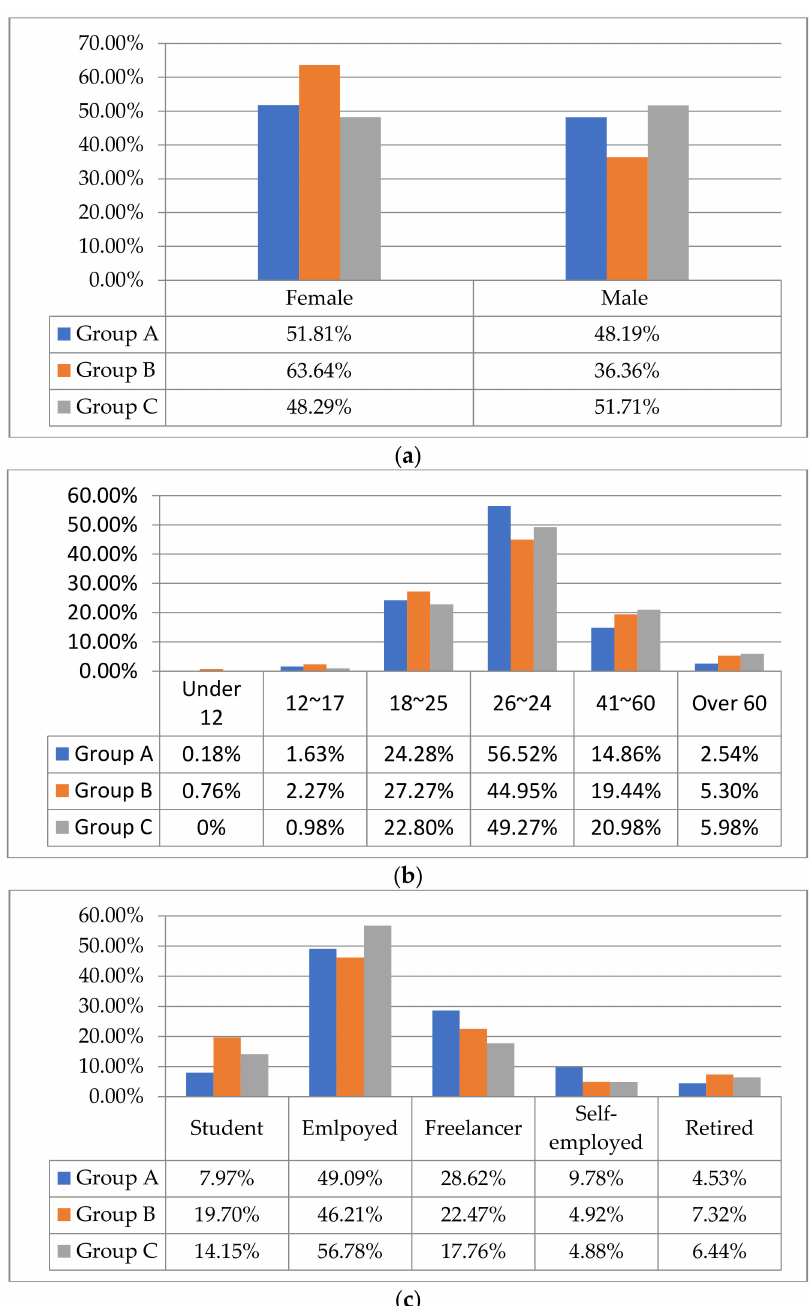
Figure 3. ( a ) Gender comparison; ( b ) age comparison; ( c ) occupation